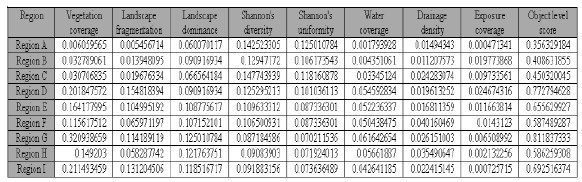
Table 2. Iterative computation Ⅰ